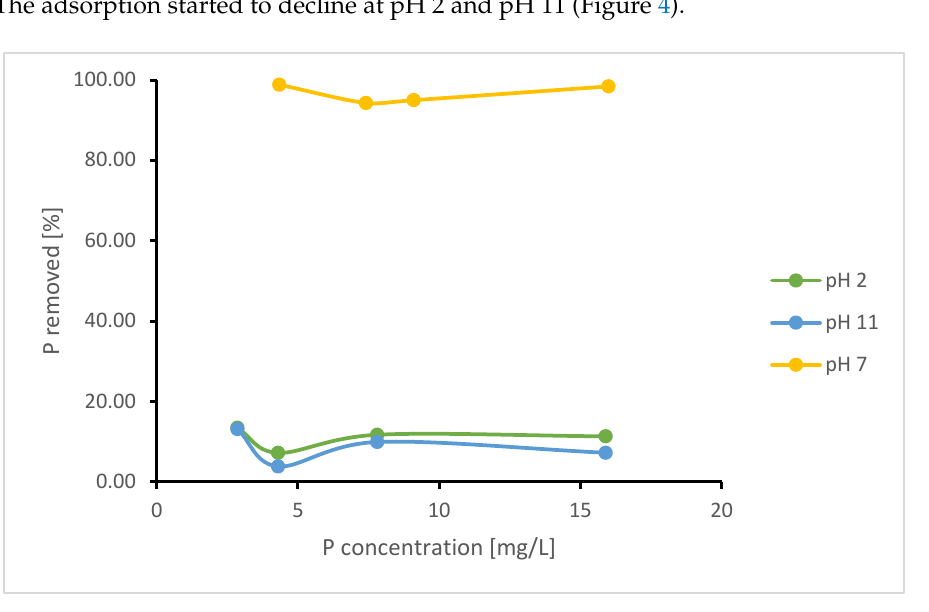
Figure 4. The effect of pH on phosphorus removal by HAOPs (adsorbent dose = 1 g/L, agitation speed = 200 rpm, temperature = 25 °C ± 2 °C, contact time = 60 min).